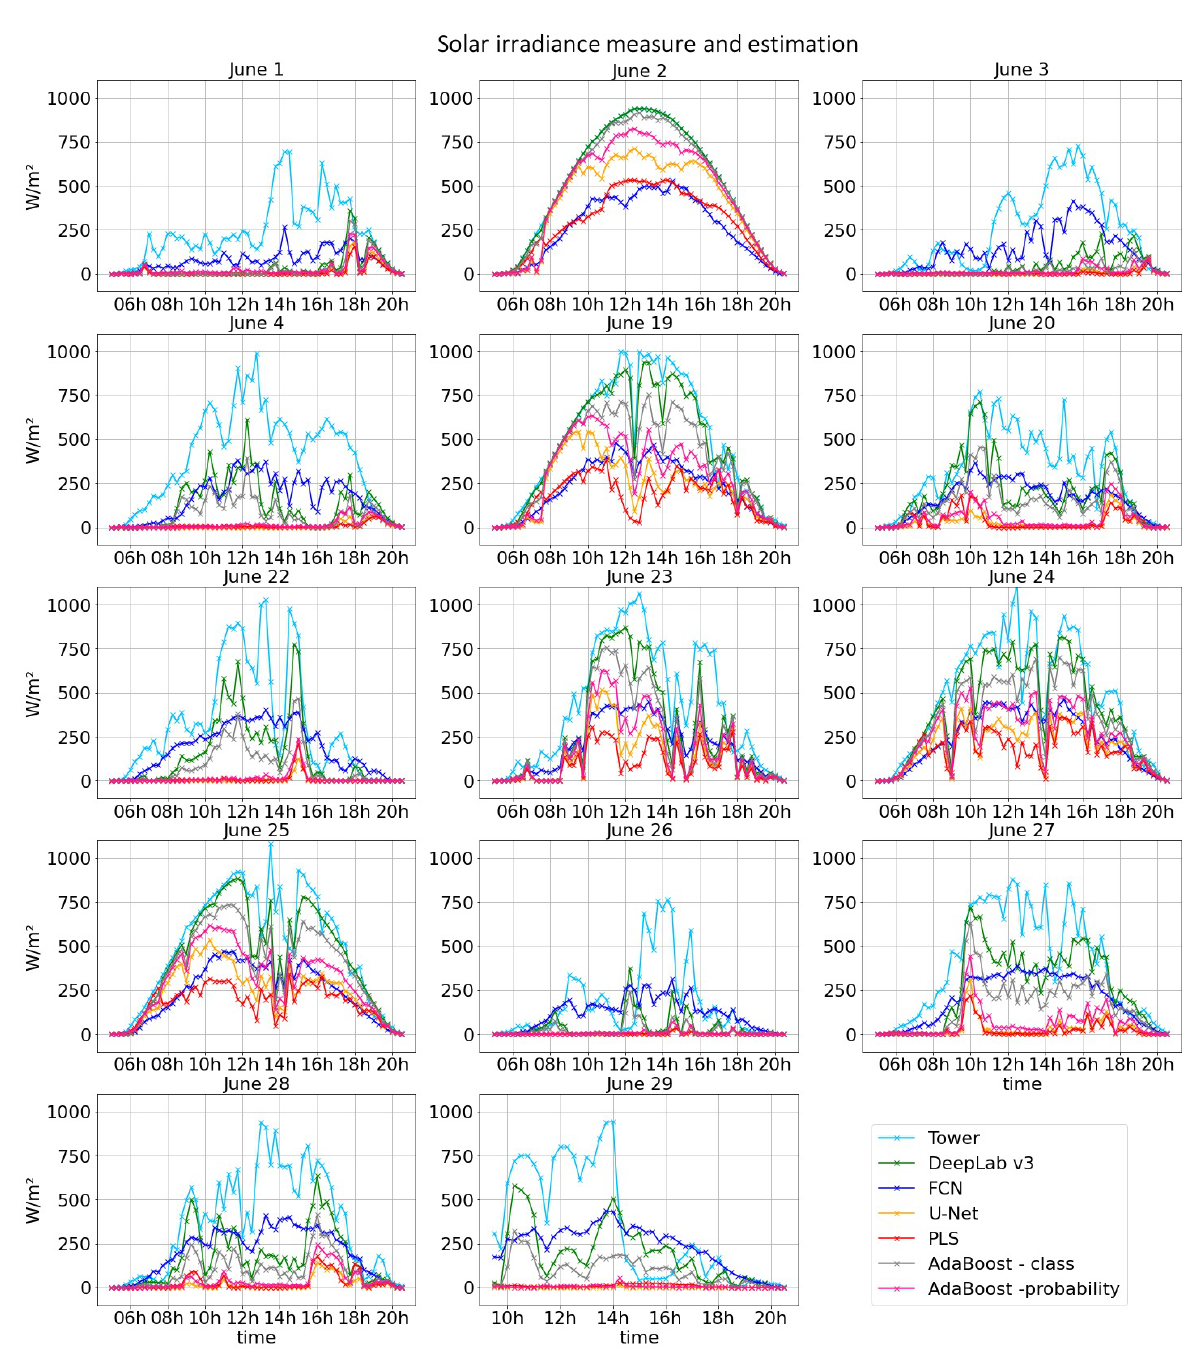
Figure A3. Measured solar irradiance (light blue) and solar irradiance estimation results in W/m 2 using 15 min-averaged cloud cover estimation and maximum solar irradiance measured on 2 June 2020 for 14 days. The tower measure on 2 June ( blue line ) is overlapped with the DeepLab v3 estimation results ( green line ), with only a small observable difference between these at 7–8